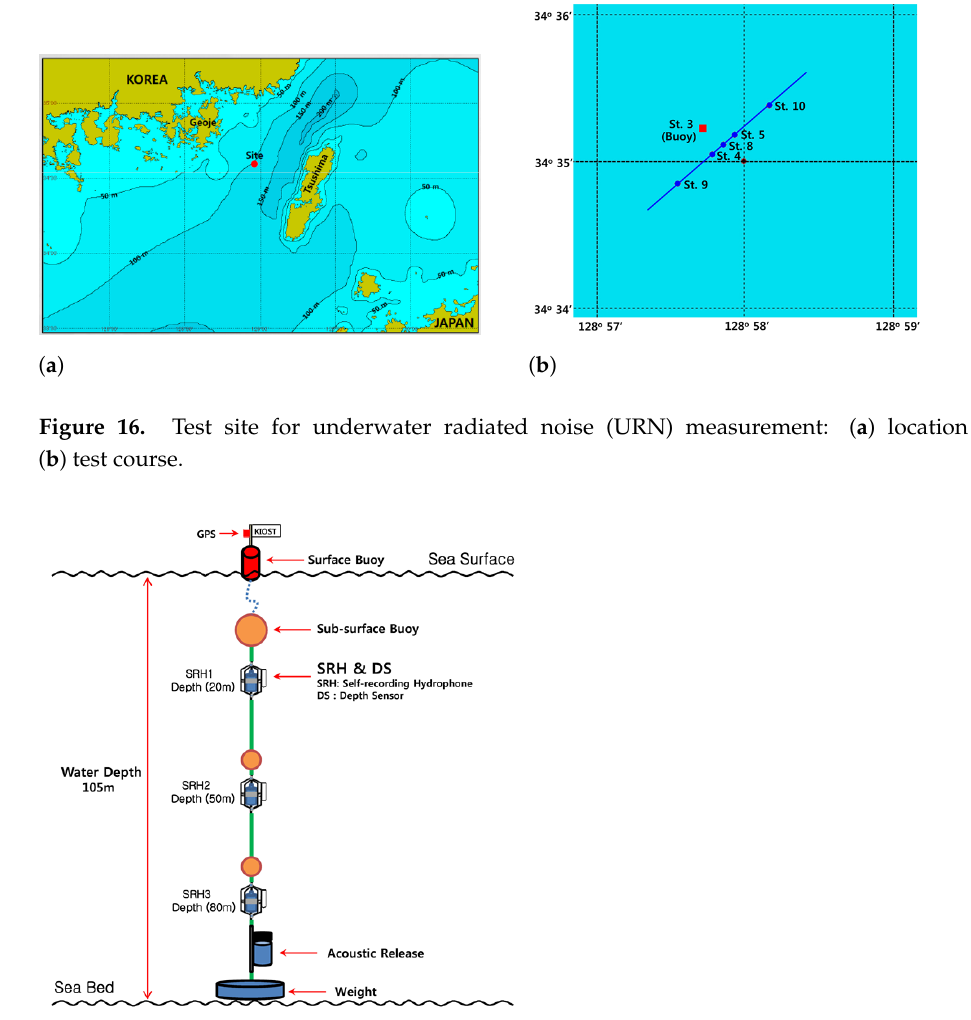
Figure 17. Schematic view of the URN measurement